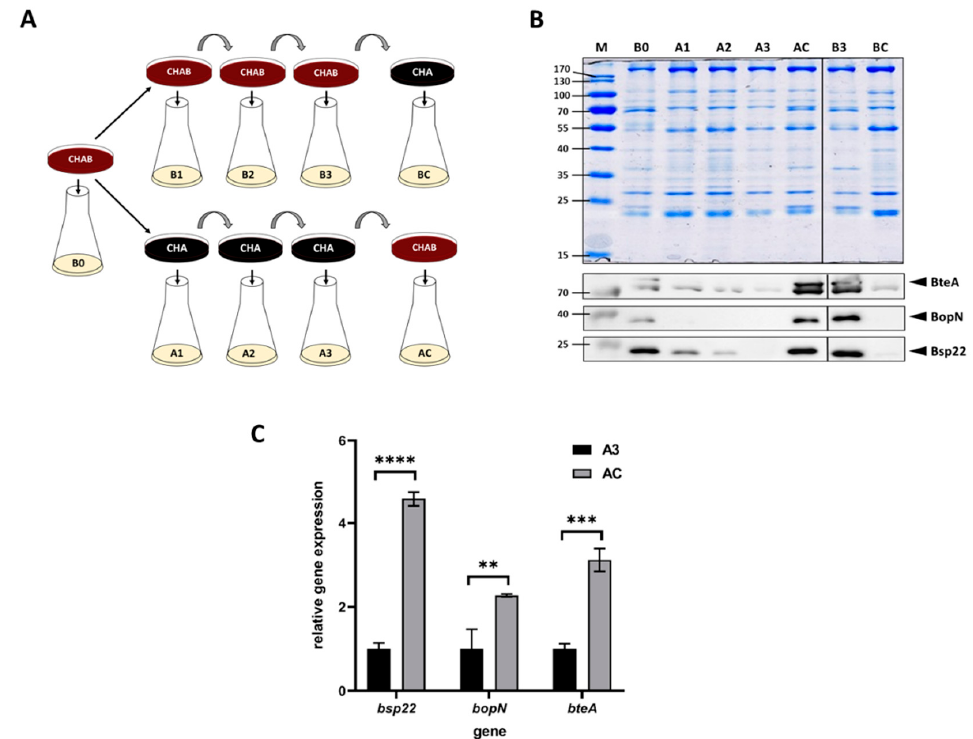
Figure 1. Blood exposure induces the expression and secretion of T3SS substrates in B. pertussis . ( A ) Scheme depicting the experimental layout and origin of samples used for Western blot and RT–qPCR analyses of cells grown in liquid cultures inoculated either from charcoal plates supplemented with blood (CHAB) or plain charcoal plates (CHA) plates. Cells from liquid cultures were used for RT–qPCR (pellets) and Western blot (supernatants) analyses. ( B ) Samples of precipitated proteins equivalent to 1 OD 600 unit were separated on 12.5% SDS–PAGE gel (upper panel) and analyzed by immunoblotting using antibodies against BteA, BopN and Bsp22 proteins. Only relevant parts of the membranes are shown; samples B1 and B2 are not shown. The result is representative of three experiments. Positions of BteA, BopN and Bsp22 proteins on the membranes are depicted with arrowheads. ( C ) RT–qPCR analysis of relative expression of bsp22 , bopN and bteA genes. Relative gene expression was compared between cells harvested from culture AC (inoculated from a plate containing blood) and culture A3 (inoculated from a plate lacking blood), which served as the control (relative expression was set to 1). Differences between samples were statistically tested by multiple comparison test using the Bonferroni’s method; **, adj. p -value < 0.01, ***, adj. p -value < 0.0004, ****, adjusted p -value <